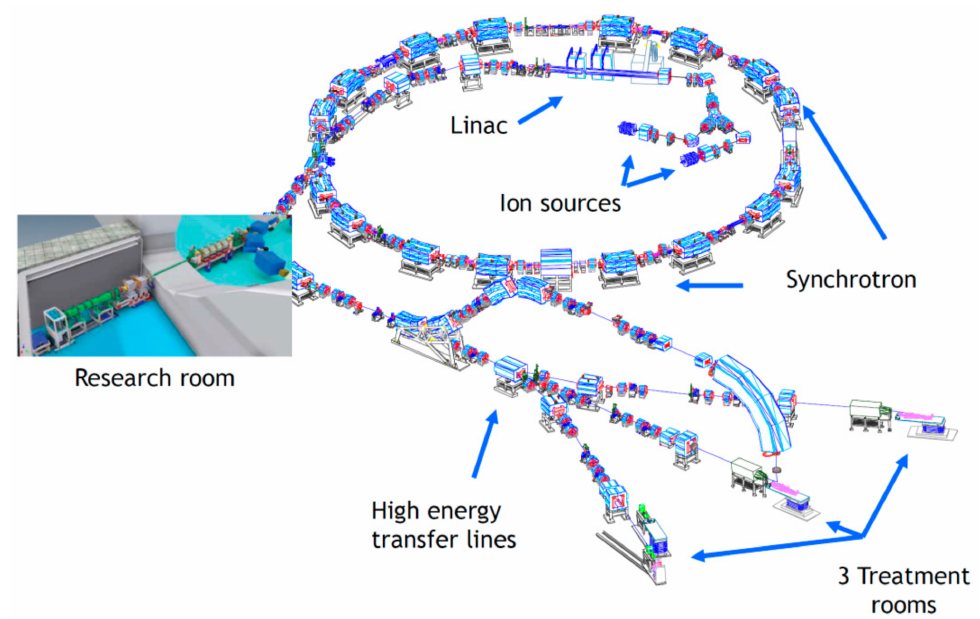
Figure 4. Model of the compact layout of the CNAO synchrotron: the injection chain is inside the ring and three horizontal beamlines are selected by a single fan-out magnet. Additionally, shown the experimental room. The diameter of the synchrotron is about 25